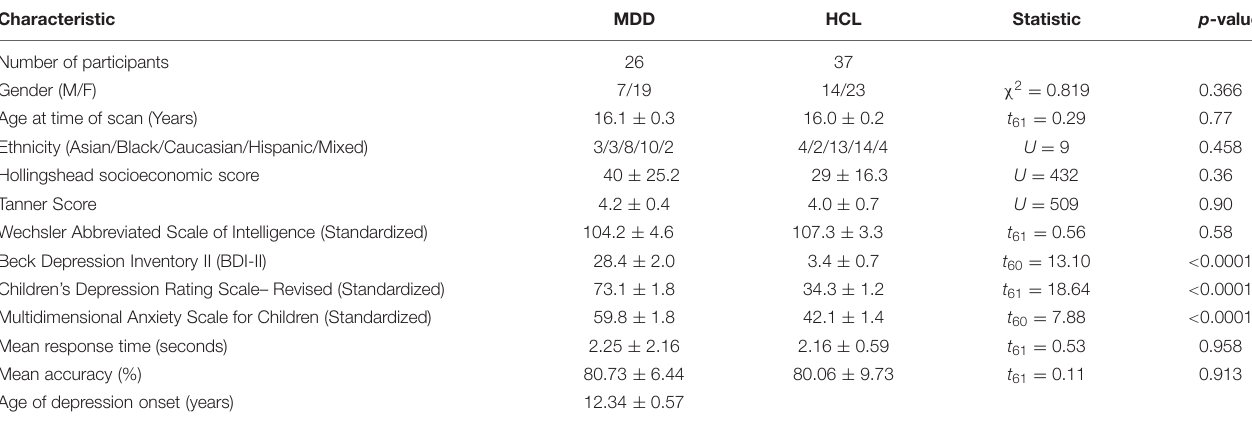
TABLE 1 | Summary of sociodemographic, clinical, and behavioral information of